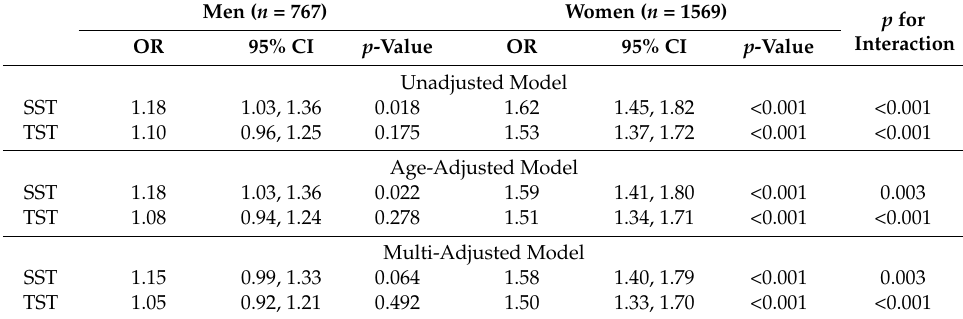
Table 3. Crude and adjusted associations of hypertension with per SD increase of skinfold thickness (2336 participants, aged 20 to 94 years old, examined in 2015). Men ( n = 767) Women ( n =